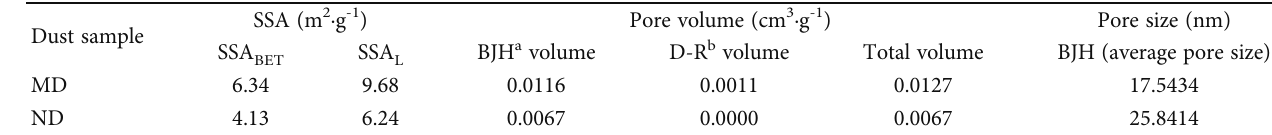
Table 3: Pore volume and structure parameters of MD and